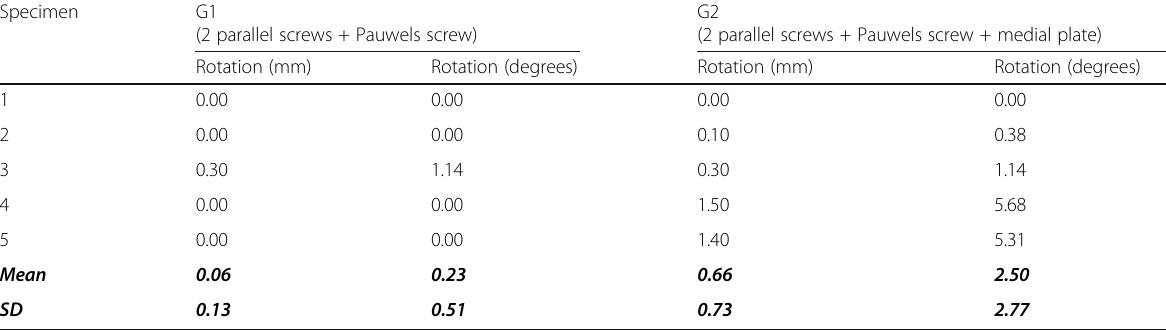
Table 2 Values for rotational deviation of the femoral head with 5.0 mm of displacement